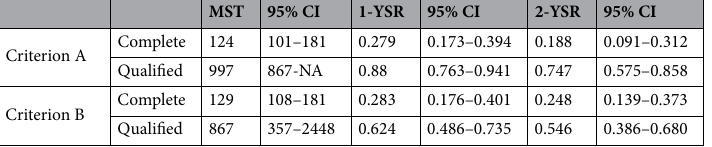
Table 3. Median survival time and 1- and 2-year survival rate. MST, median survival time; YSR, Year survival rate; CI, confidence